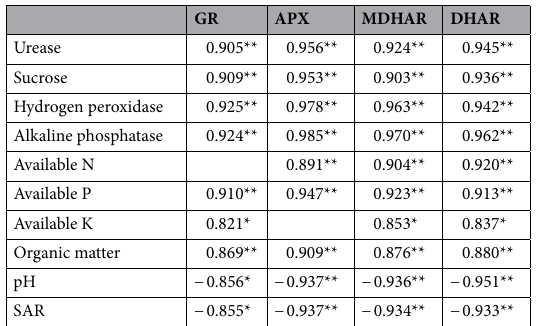
Table 7. Pearson’s correlations between soil characteristics and the AsA–GSH cycle enzyme activity. **P < 0.01, *P <